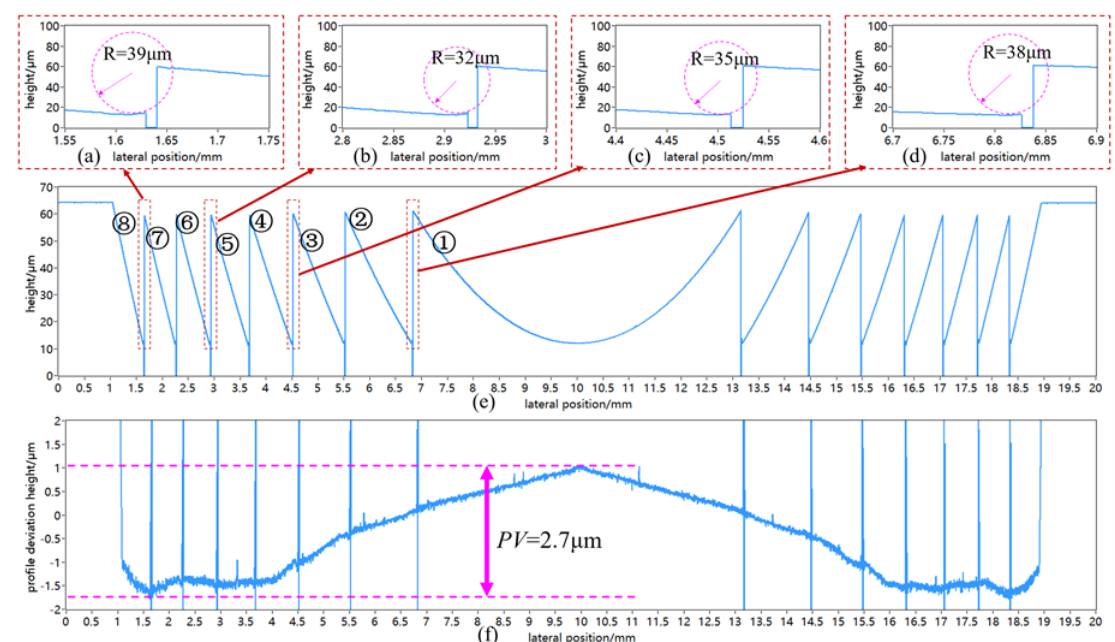
Figure 13. Simulation and measurement results of the surface waviness error of ground Fresnel micro- structured molds.